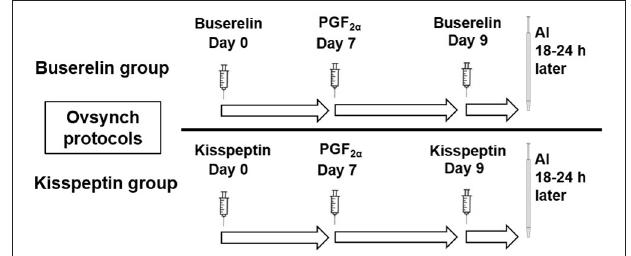
FIGURE 2 | Schematic representation of Ovsynch protocols tested in Murrah buffaloes for oestrus synchronization using either buserelin or kisspeptin. On day 0 and 9, animals in buserelin group were treated with buserelin (10 µ g/animal, IV) while that in kisspeptin group received kisspeptin (20 µ g/kg, IV). PGF 2 α (500 µ g, IV) was administered on day 7. Fixed time AI was done 18–24h post second dose of buserelin or kisspeptin.